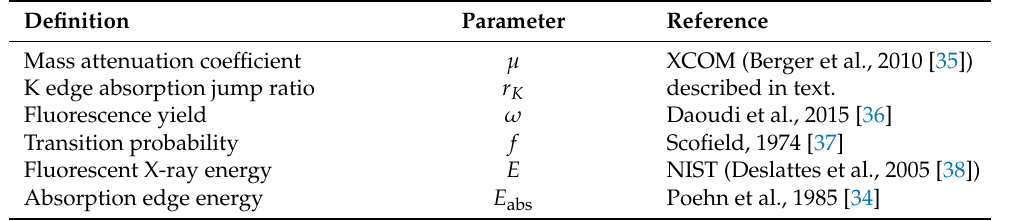
Table 6. References to the fundamental parameters.